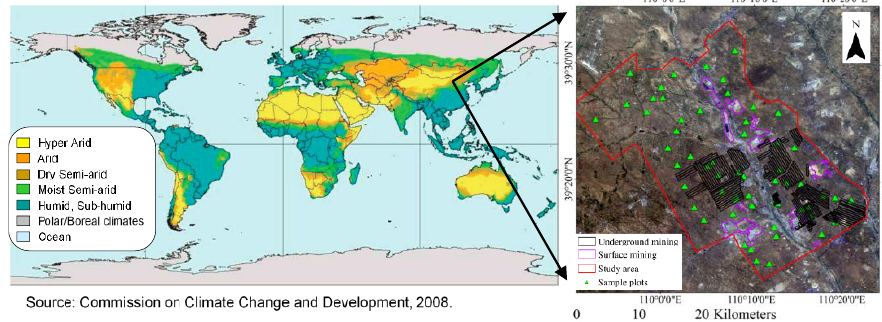
Figure 1. The geographical location of the study